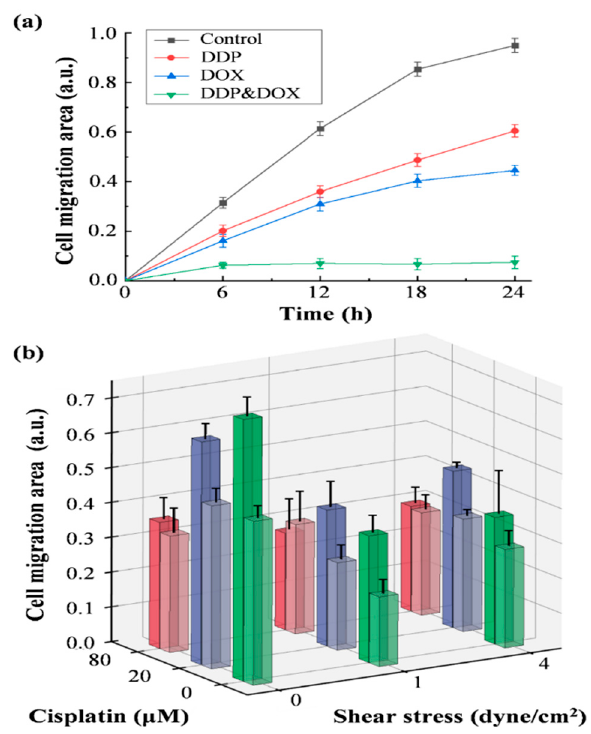
Figure 5. ( a ) Cell migration area of HeLa in 24 h influenced by DDP, DOX, and their compounds vs. the control group. ( b ) Cell migration area of HUVEC under different shear stress and concentration of cisplatin at 6 h (light color) and 12 h (dark color) ( n =